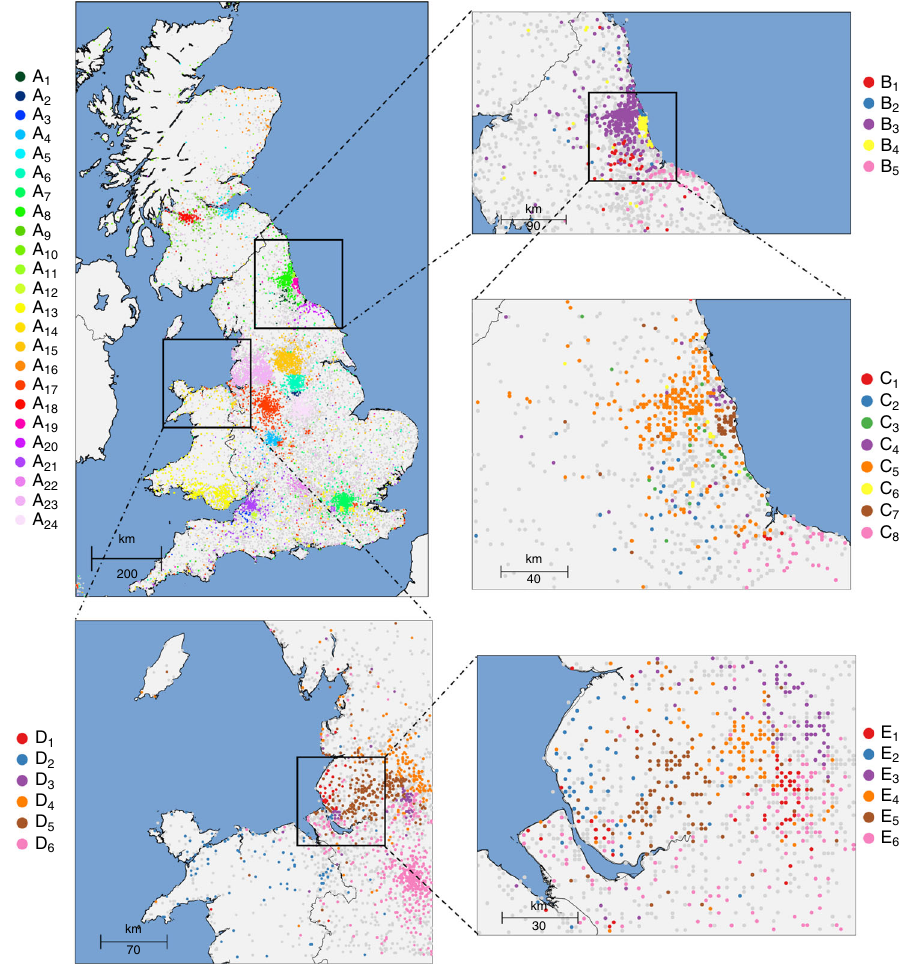
Fig. 2 Fine-scale population structure in the UK. Hierarchical clustering of 432,866 individuals from the UK Biobank dataset based on the sharing of IBD segments within the past 10 generations. Individuals in clusters with <500 samples are shown in light gray. We observed 24 main clusters across the country (top left) and we re fi ned two regions, corresponding to Newcastle (NE) (top right) and Liverpool (L) (bottom), revealing fi ne scale population structure. No relationship between clusters is implied by the colors or cluster labeling across different plots (details are provided in Methods